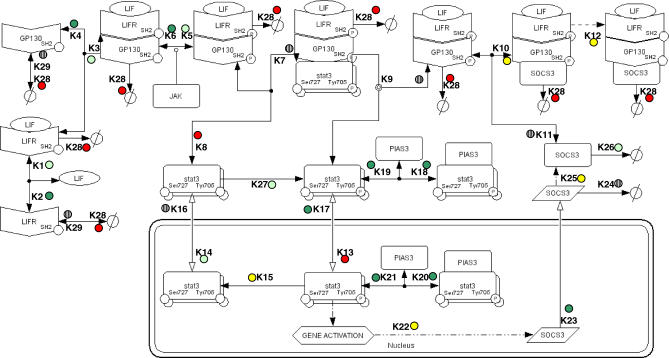
Network Structure of the Jak/Stat3 Pathway Shows Scheme for LIF-induced Activation of Stat3Closed arrows indicate biochemical reactions, open arrows show transport such as transport into nuclear compartment, and double arrows indicate reversibility. All surface receptors and complexes are internalized similarly, internalized complexes are degraded, and new receptors are constitutively produced. Color-coded dots next to kinetic parameters correspond to grouping of parameters from Figure 5 as explained in text.